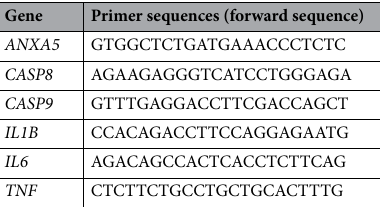
Table 3. Primer sequences of the investigated genes.